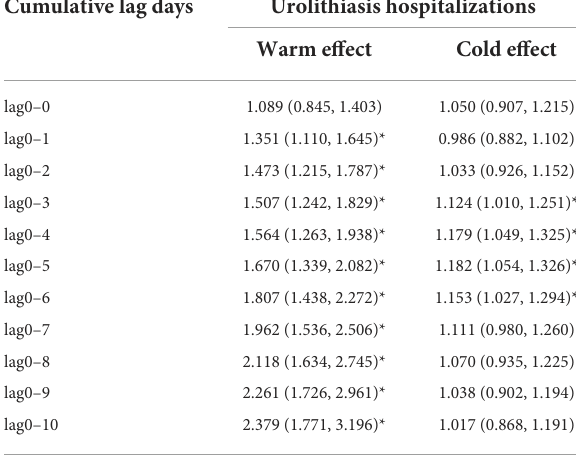
TABLE 3 Cumulative warm and cold effects of temperature on hospitalization of